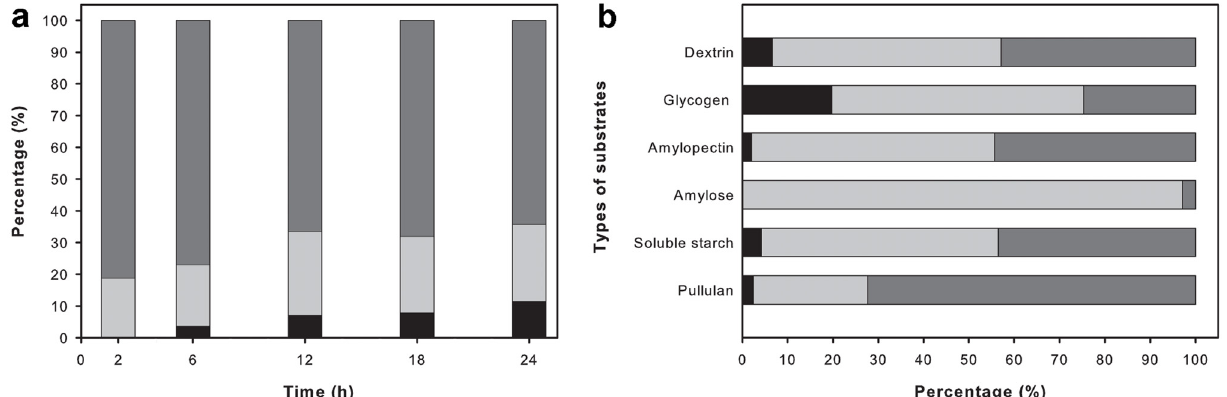
Figure 3. Analysis of reaction products using HPLC. ( a ) Production of glucose (black), maltose (light grey), and maltotriose (grey) by ApuASK on pullulan at different time intervals; ( b ) Production of glucose (black), maltose (light grey), and maltotriose (grey) by ApuASK on individual substrate of pullulan, soluble starch, amylose, amylopectin, glycogen, and